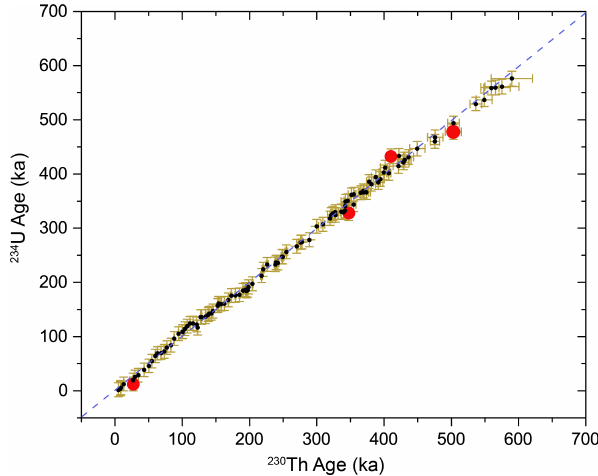
Figure 3. Plot of 234 U ages against 230 Th ages between 4 and 590ka. The 2 σ uncertainty shown by brown error bars. The dashed blue line is the 1 : 1 line, and the red dots refer to four samples in- consistent with this